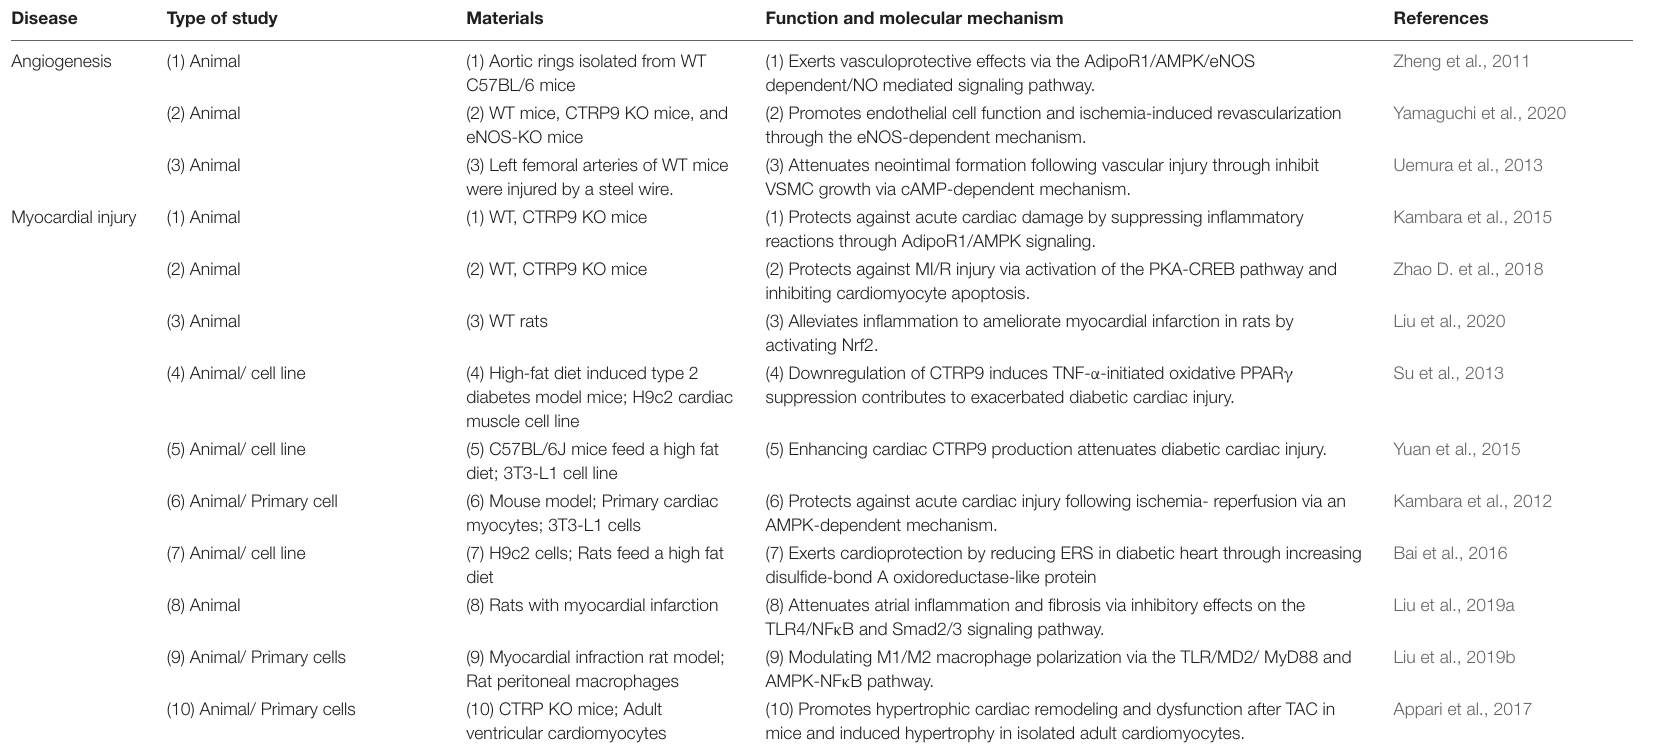
TABLE 3 | The experimental study characteristics of CTRP9 in cardiovascular